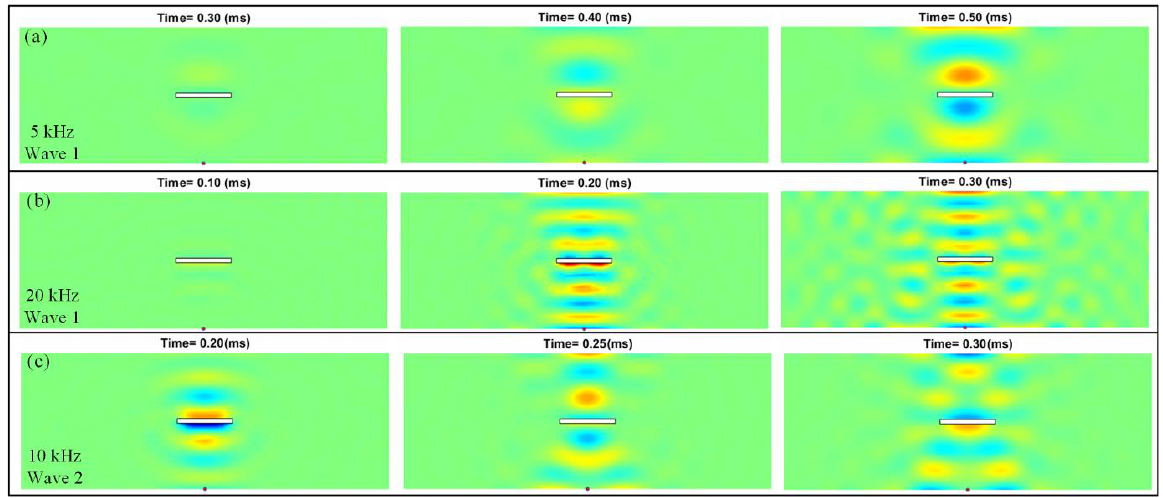
Figure 11. Differential instantaneous wave field when the excitations are ( a ) 5 kHz five-cycle tone burst, ( b ) 20 kHz five-cycle tone burst, and ( c ) the 10 kHz Ricker wavelet.